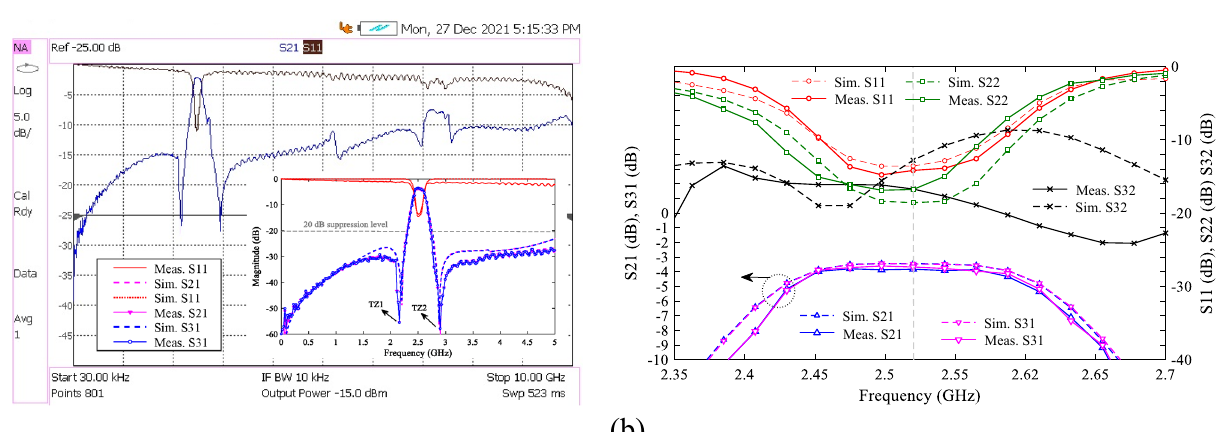
Sim.S11 Meas.S11Sim.S22